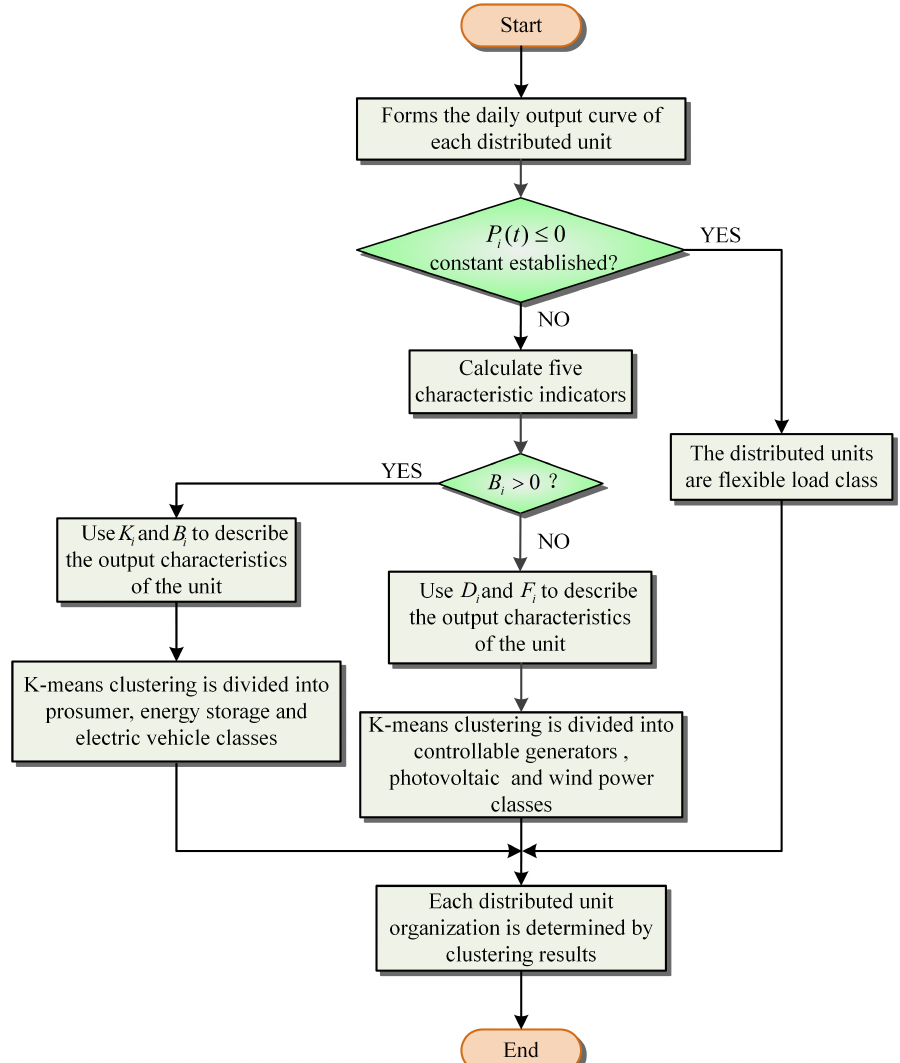
Figure 3. Flow chart of the distributed unit classification and